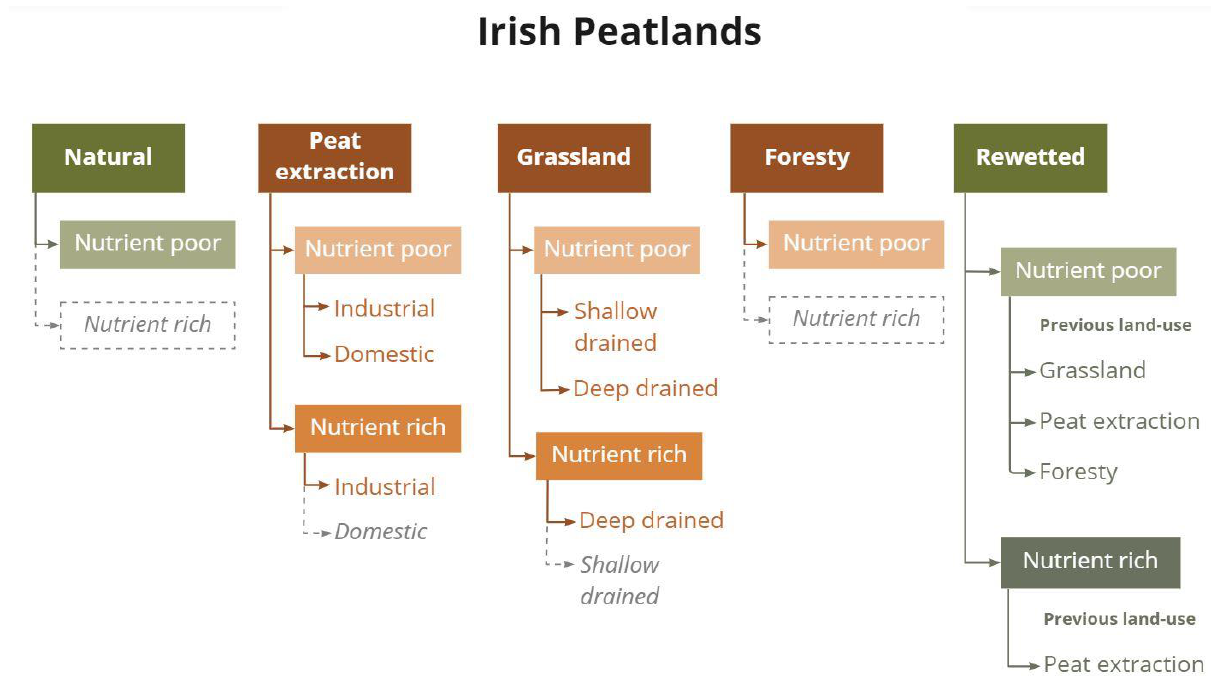
Figure 1. Land use classification used for Irish country-specific emission factor (EF) calculations. Green cells represent rewetted and near-natural peatlands, and brown cells represent drained peatlands. Brighter and lighter colours represent nutrient-rich and nutrient-poor peatlands respectively. Note that categories in italics lacked measured GHG fluxes and not all categories had sufficient annual GHG flux data to derive suitable EFs.